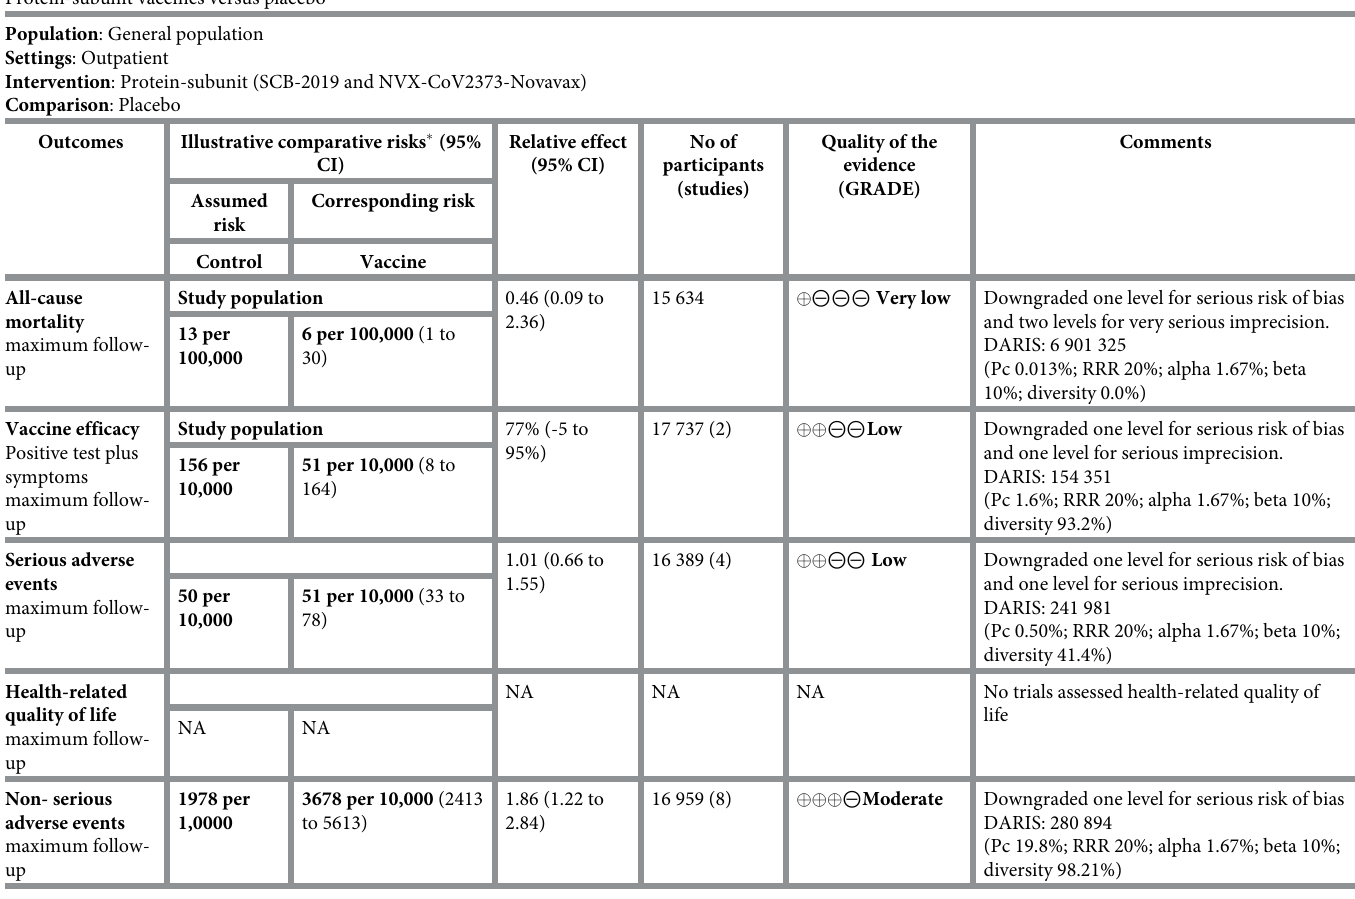
Table 3. Summary of findings (protein-subunit vaccines). Protein-subunit vaccines versus placebo Population : General population Settings : Outpatient Intervention : Protein-subunit (SCB-2019 and NVX-CoV2373-Novavax) Comparison :